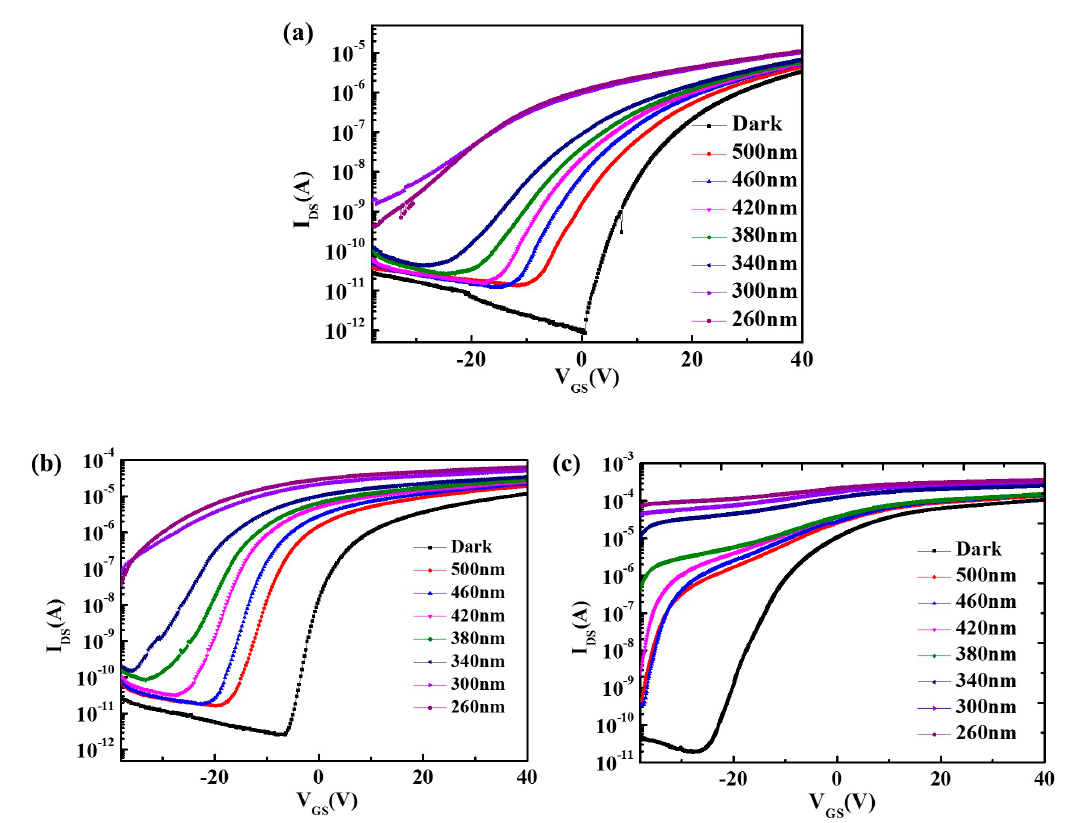
Figure 6. Transfer characteristic curves of ( a ) sample A, ( b ) sample B, and ( c ) sample C under dark and 260–500 nm illumination.